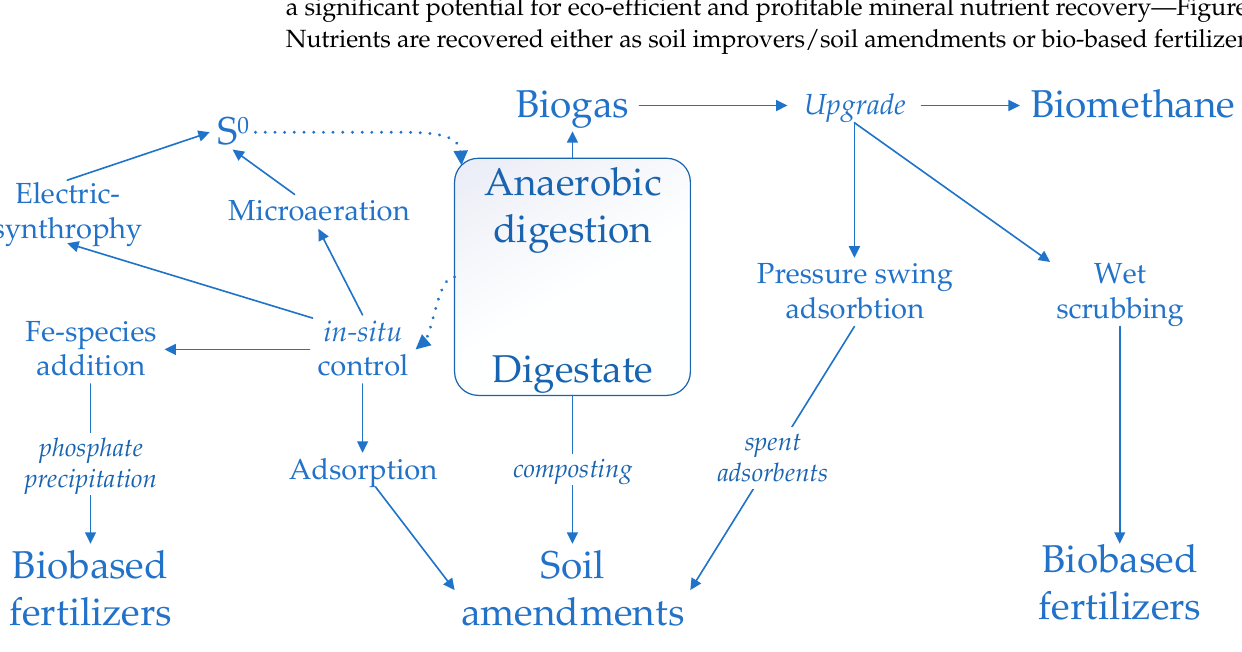
Figure 3. Potential of the technologies used to reduce hydrogen sulfide and ammonia in the biogas produced from anaerobic digestion to recover nutrients.